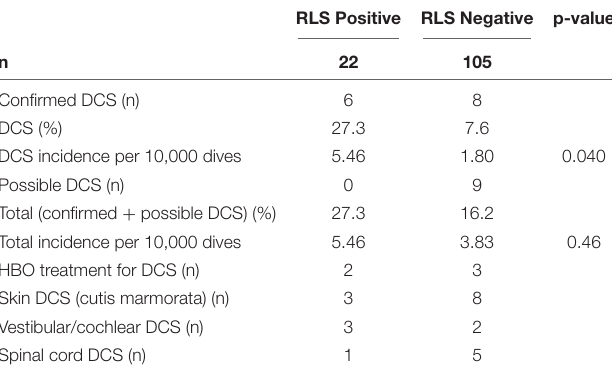
TABLE 3B | Decompression sickness events (“blinded” divers